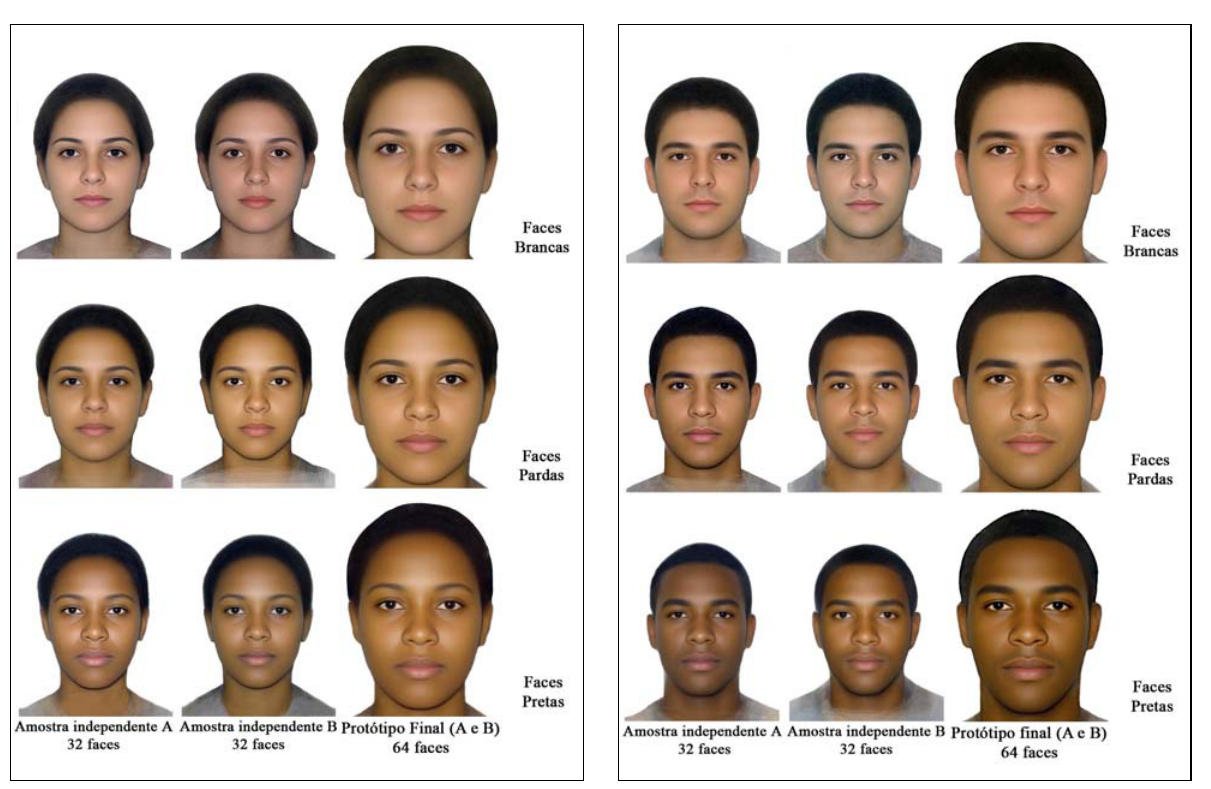
Figura 2 . Protótipos faciais femininos. As duas primeiras